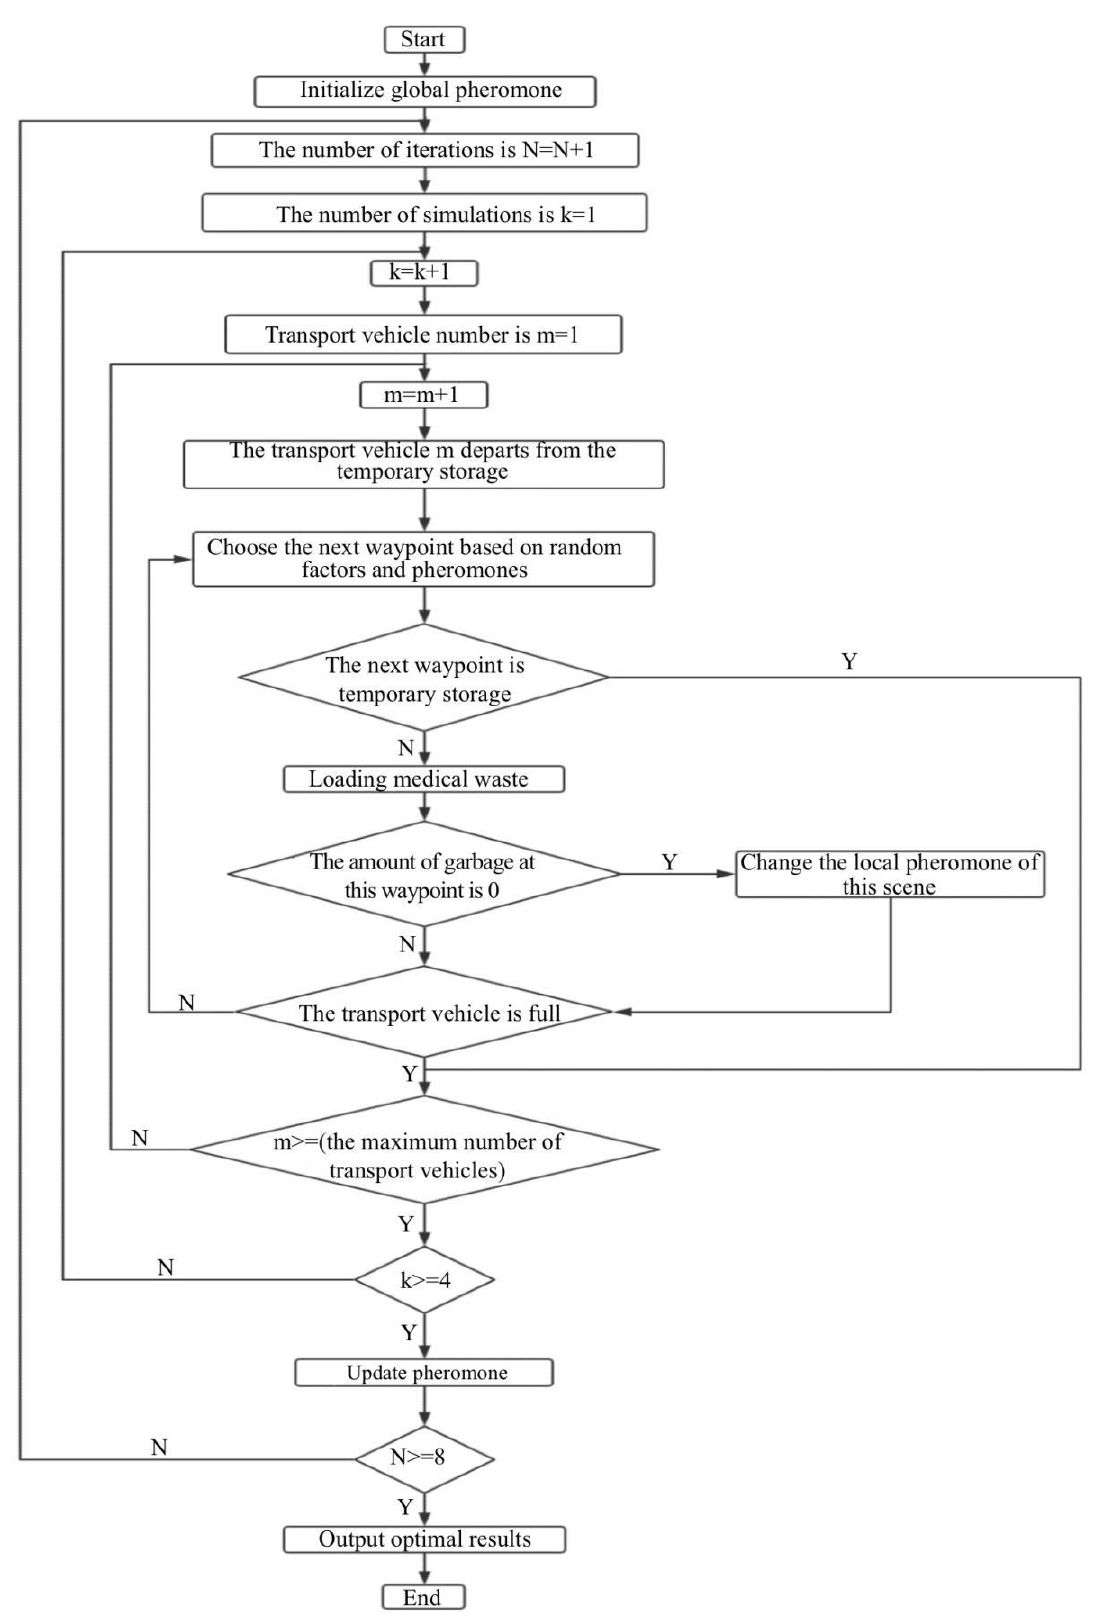
Figure 4. The flow chart of the algorithm.